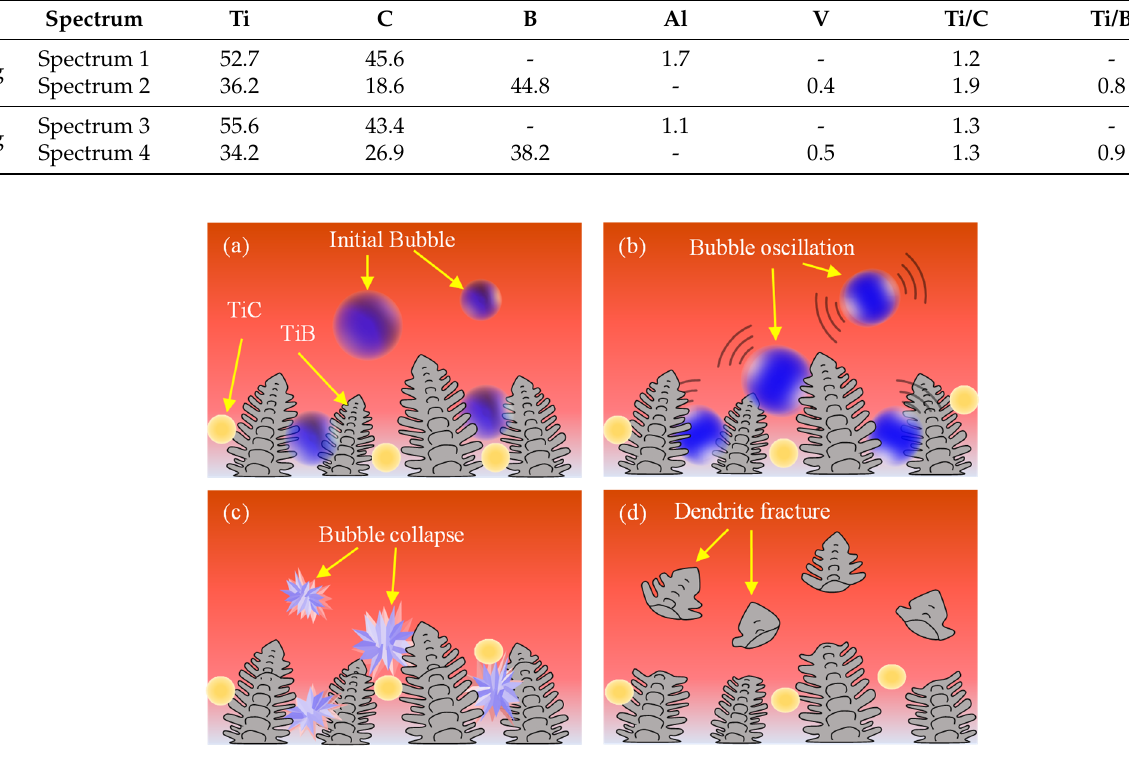
Figure 9. The main effect mechanism of ultrasonic vibration changing the microstructure of laser cladding coating: ( a ) Initial cavitation bubble, ( b ) Cavitation bubble oscillation, ( c ) Cavitation bubble collapse, ( d ) Dendrite